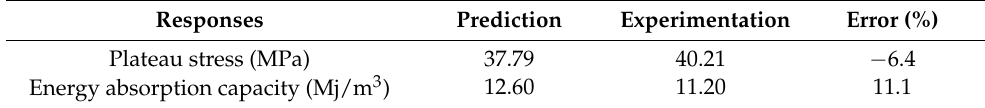
Table 10. Comparison of confirmation test with predicted